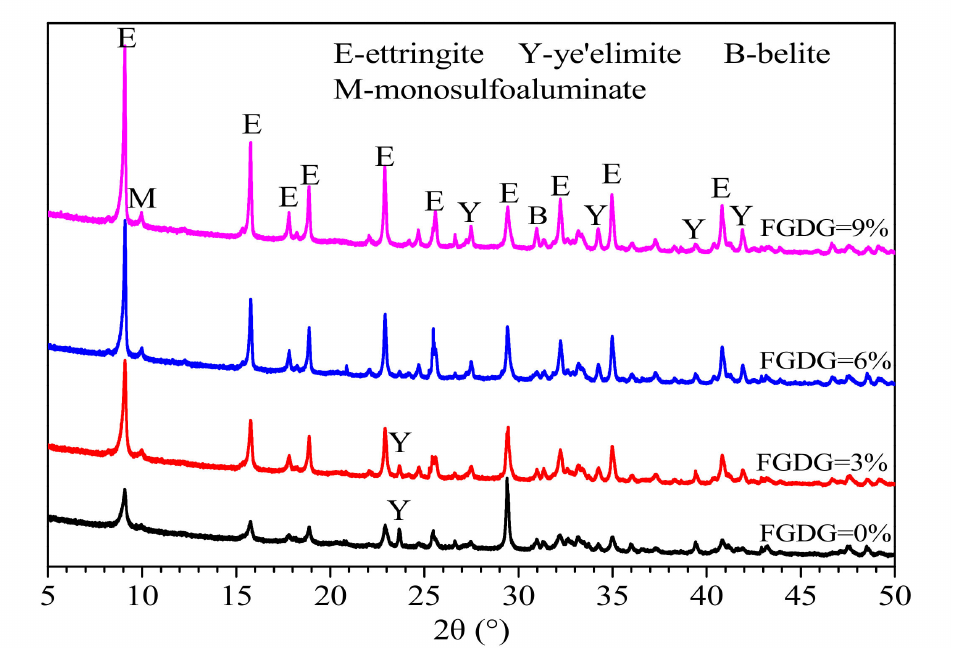
Figure 6. XRD patterns of CSAC-GGBFS mixtures blended with different FGDG content hydrated for 120